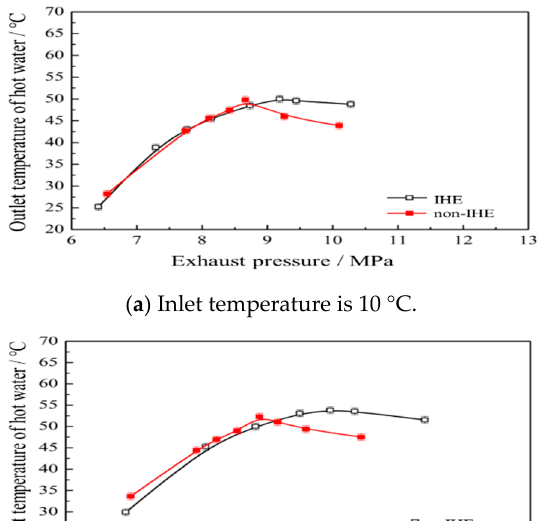
Figure 7. Comparison between heating and COP with and without IHX at different inlet temperatures of water source.